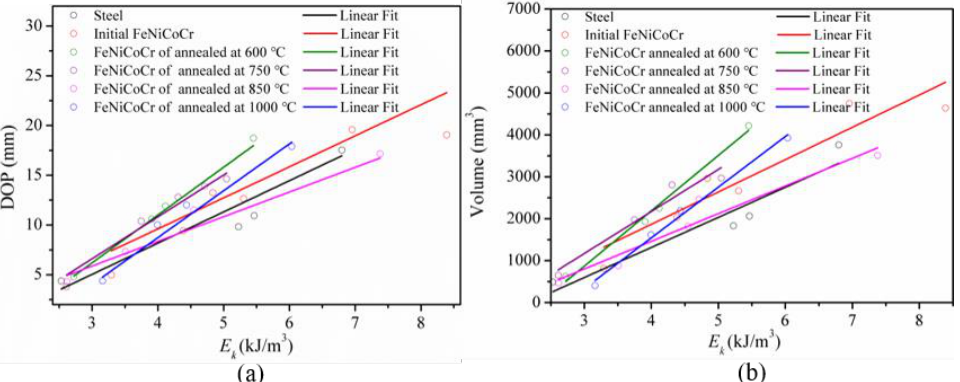
Figure 16. The results of the projectiles penetrating the targets: ( a ) The depth of penetration of the projectiles penetrating the targets and ( b ) The volume of crater of the projectiles penetrating the targets